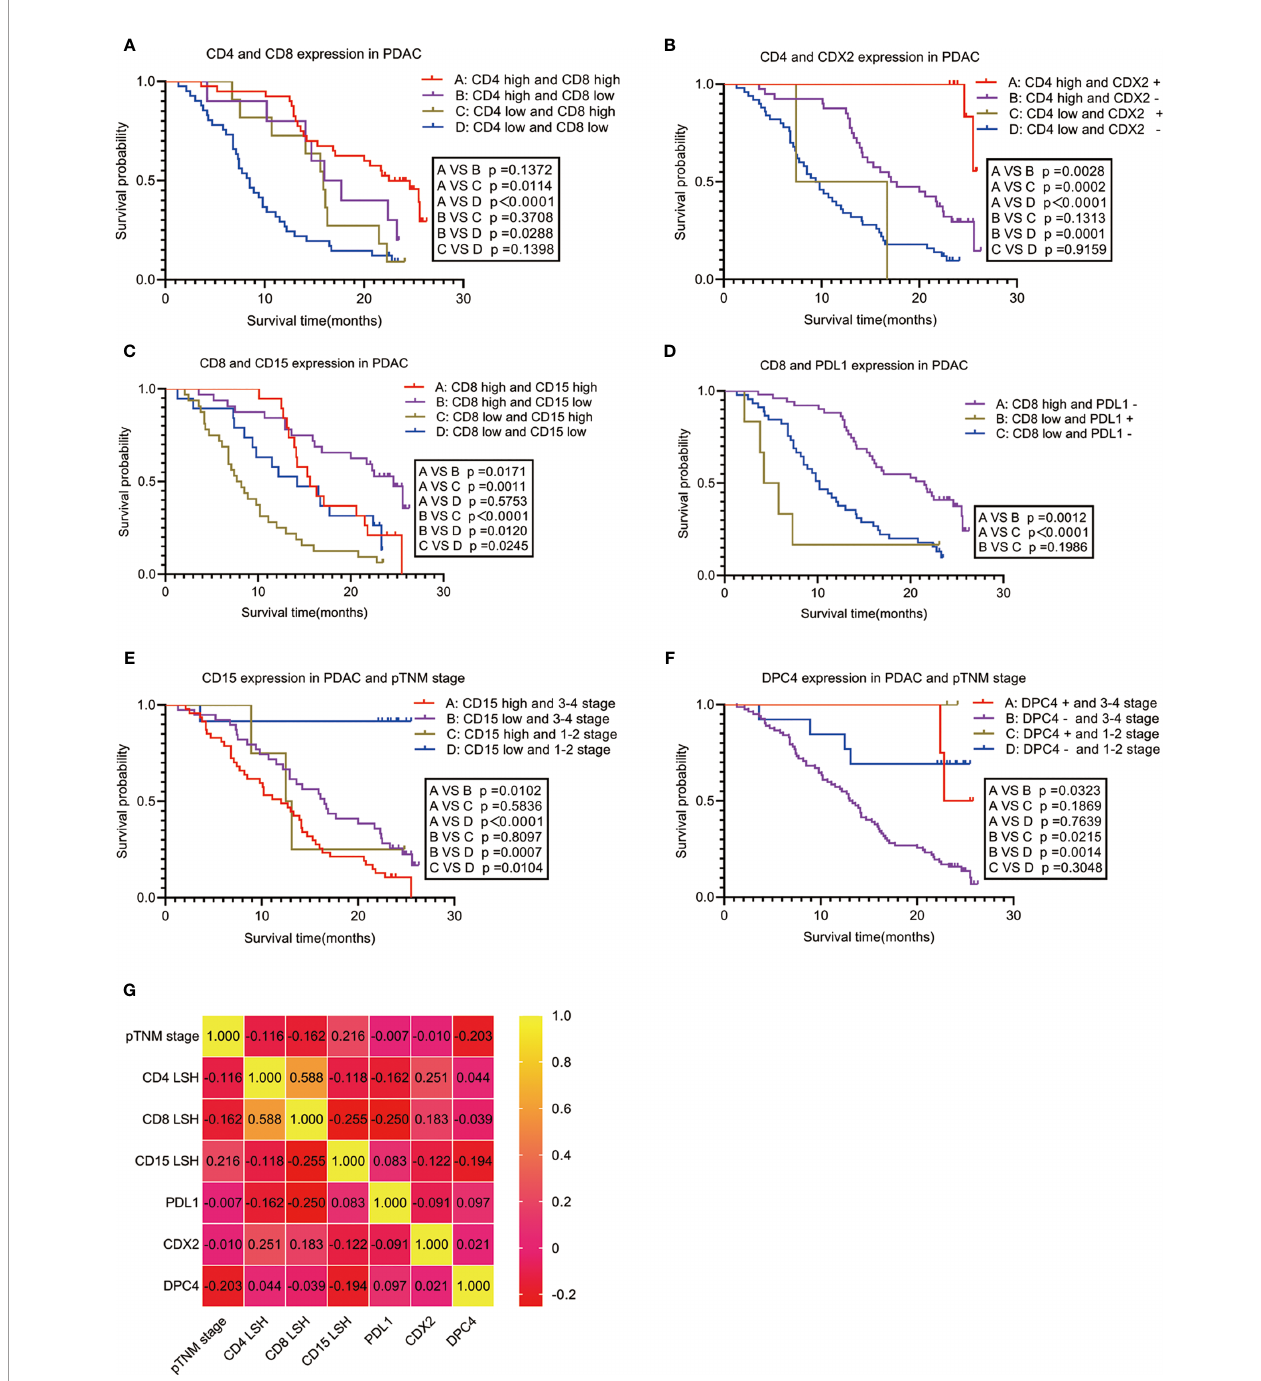
FIGURE 3 | Correlation between PDAC-independent prognostic parameters and their combinations with OS. Survival analysis (A – F) and a heat map of the correlation coef fi cient matrix (G) of correlated combination variables for the prediction of PDAC prognosis. PDAC, pancreatic ductal